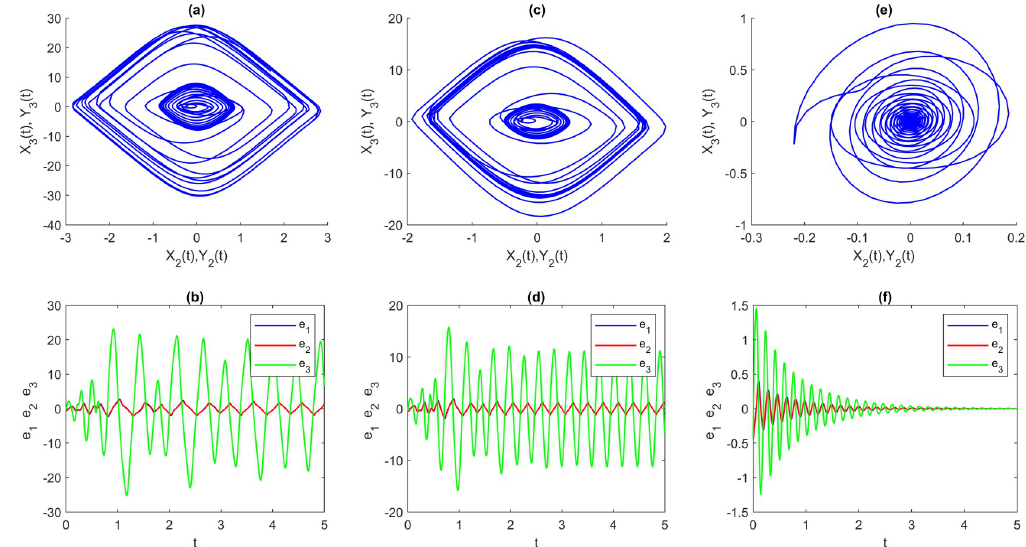
Fig 9. Without delay multi-FONNSMD synchronization with different value of parameters. (a) A = P = diag[1 1 1], (b) A = diag[1 2 2], P = diag[2 2 2], and (c) A = diag[10.5 10.5 0.5], P = diag[20.5 20.5 20.5]. (a), (c) and (e) are synchronization of FONNSMD systems while (b), (d) and (f) are dynamic error of FONNSMD systems.